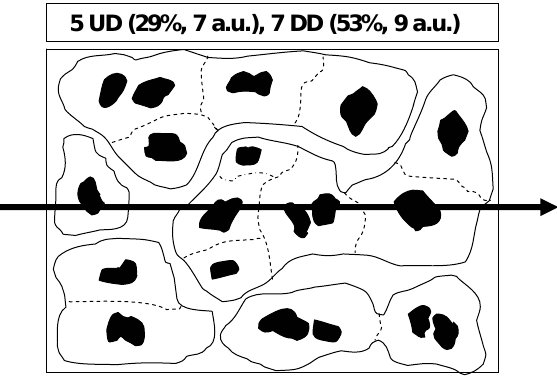
Fig. 5. Top view on the convectively active ABL. The idealized scenario is in qualitative agreement with Figure 6. Well-defined small areas of updrafts (UD, black) are surrounded by zones with downward motion (DD, white). The DD zones partly merge (in- dicated by dashed lines). The thick horizontal vector, pointing to the east, illustrates what a Doppler lidar observes in case of east- erly winds regarding draft frequency (5UD, 7DD zones), occur- rence duration or horizontal extent (updraft mean extent of 7 arbi- trary units, a.u., downdraft mean extent of 9a.u.), and how much of the area is covered by updrafts (29%) and by downdraft zones (53%). The remaining area (18%) is covered by environmental air ( − 0.1m/s <w <